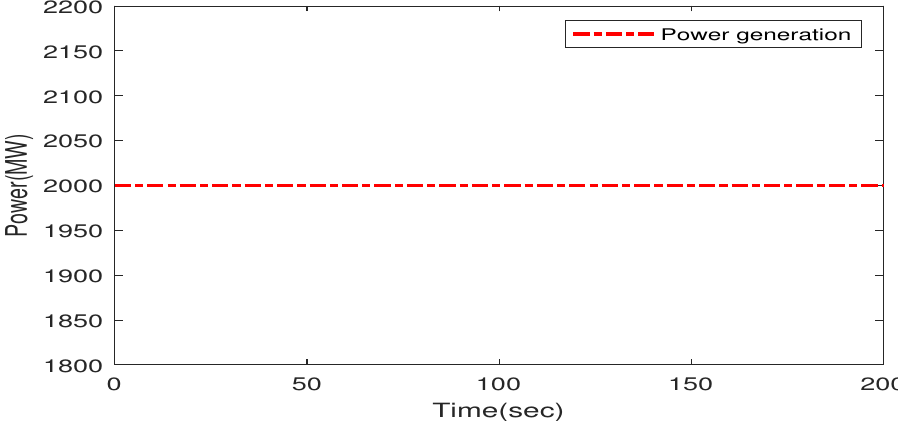
Figure 3. Total active power output without capacity